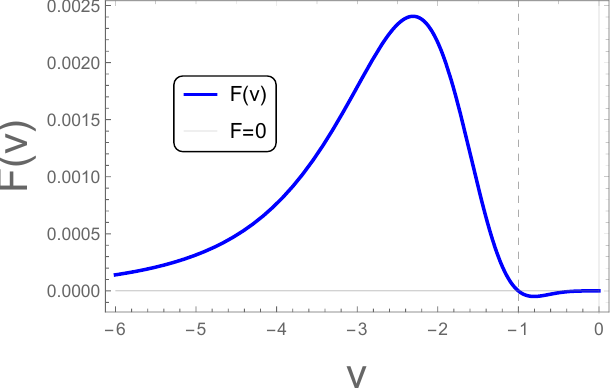
Figure 4. The energy flux, Equation (13), is asymptotically zero at v = − ∞ and v = 0 − . The total energy, as we shall see in Equation (19), is therefore finite. Notice the emission of negative energy flux near late advanced times. Here, M = 1. We have a convenient scale such that at v = − M , the energy flux is zero, F ( − 1 ) =